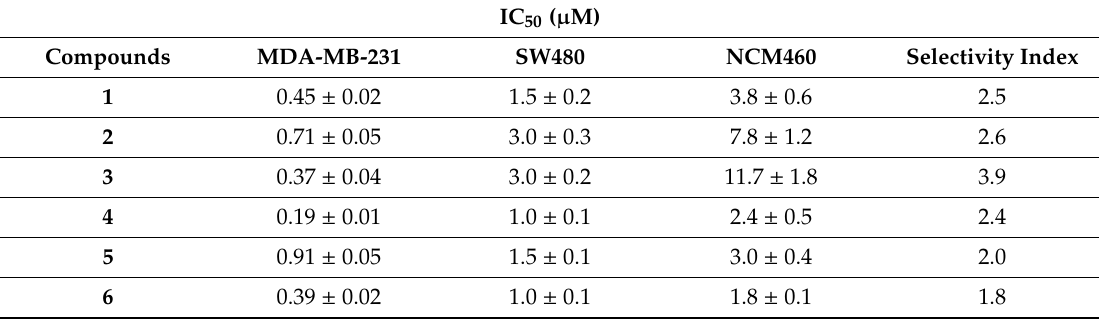
Table 3. IC 50 values determined at 48 h incubation of iron compounds ( 1 – 6 ) against